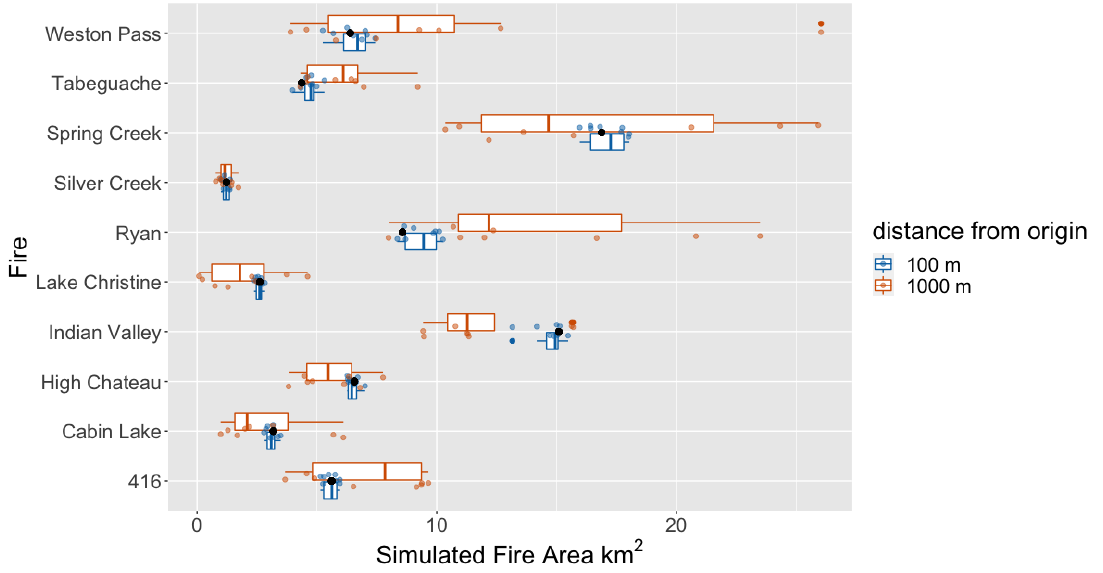
Figure 6. Forecast burned area for each case study resulting from simulations initiated at the detection time and all 17 initiation points.